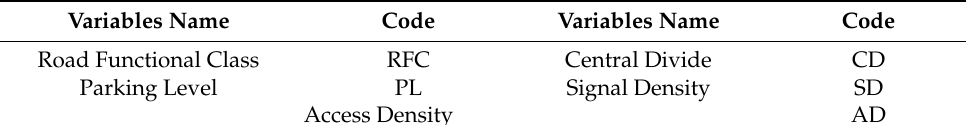
Figure 13. Adjustment factor development ( a ) and standardization for the existence ( b ) of road function.